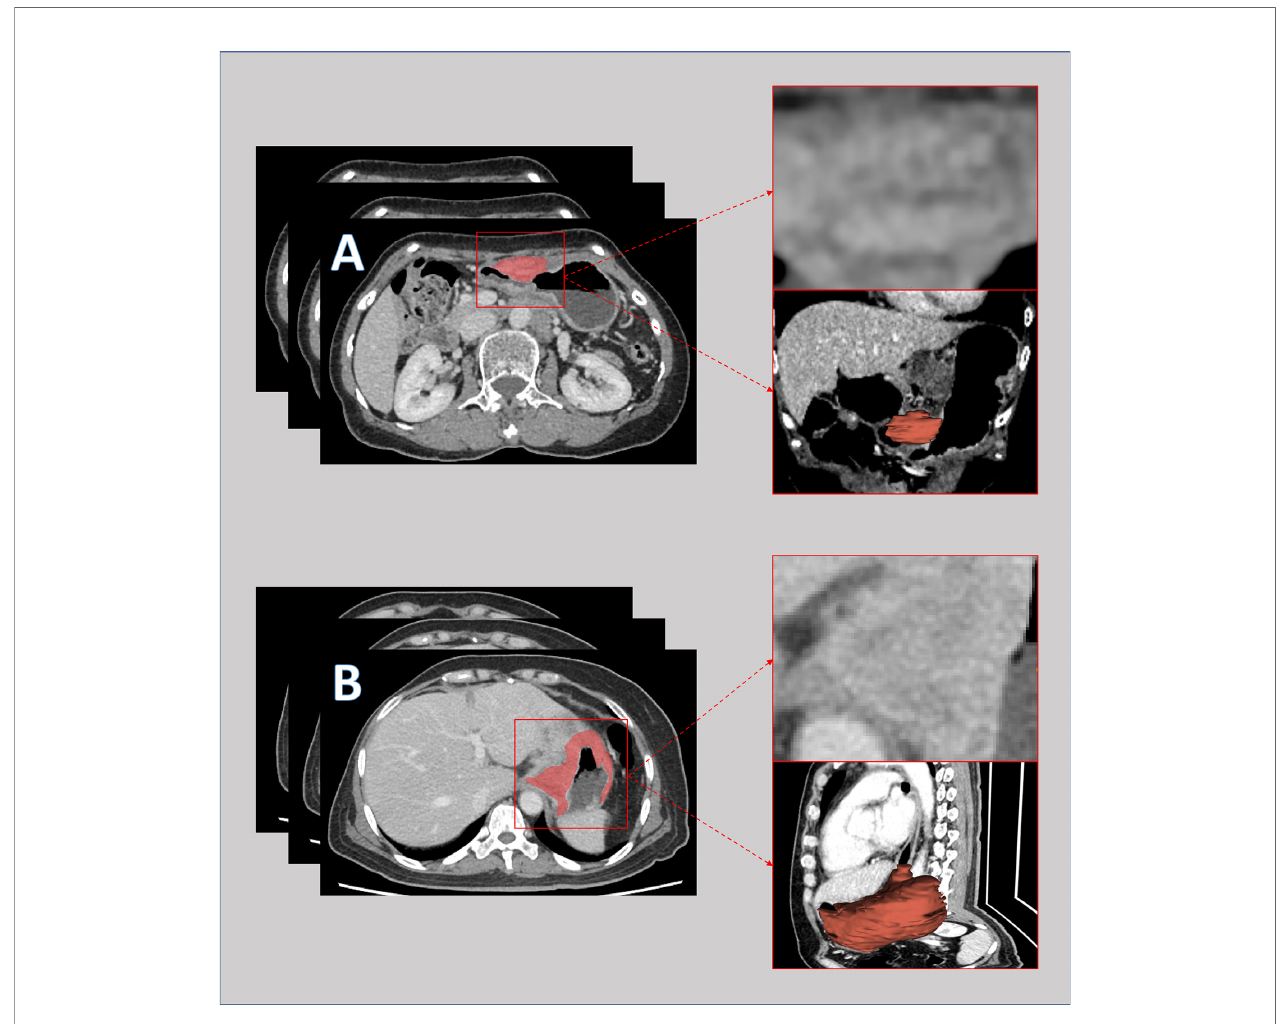
FIGURE 1 | Pre-intervention venous-phase computed tomography images of a patient with major response (A) and a patient with minor response (B) to neoadjuvant chemotherapy. The lesions were delineated slice by slice and merged into a 3-dimensional region for features